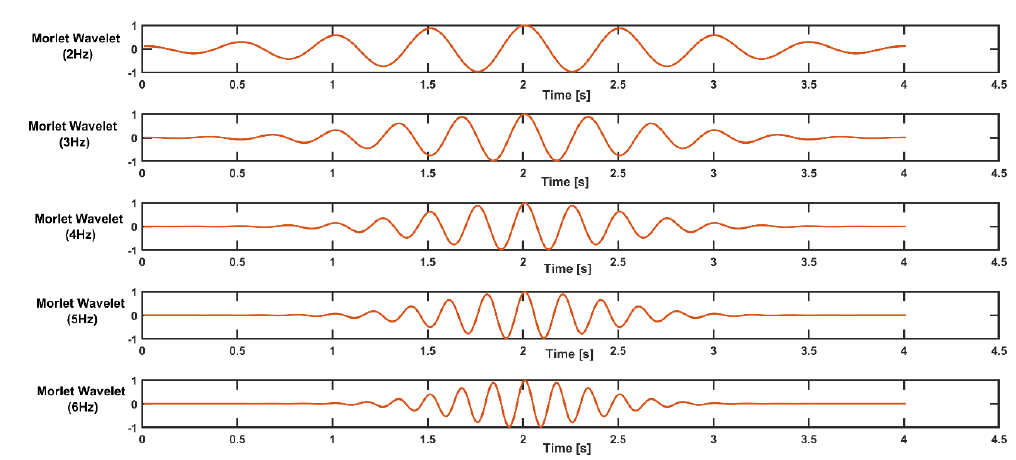
Figure 7. Morlet wavelets for different frequencies from 2 to 6 Hz.